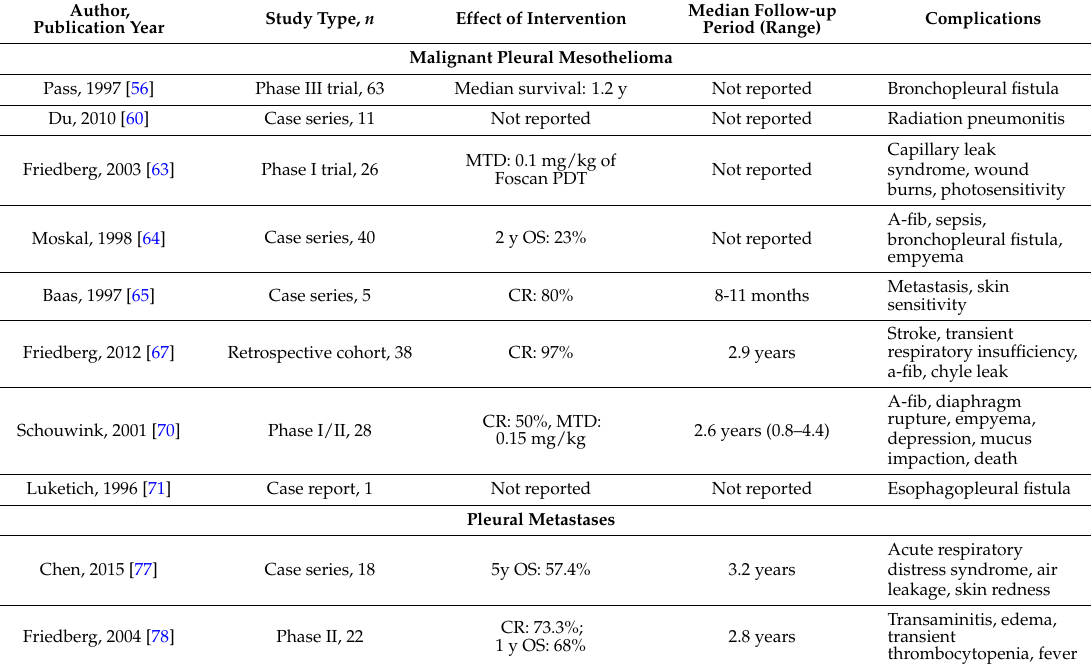
Table 2. Summary of primary studies on PDT in pleural